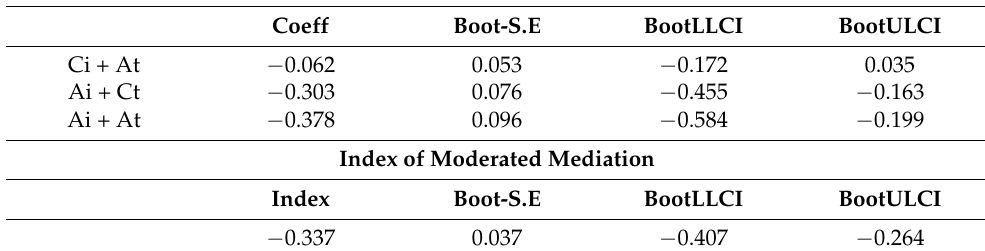
Table 5. The mediating role of the effects of cognitive fluency in combination design style and construal level on response time.